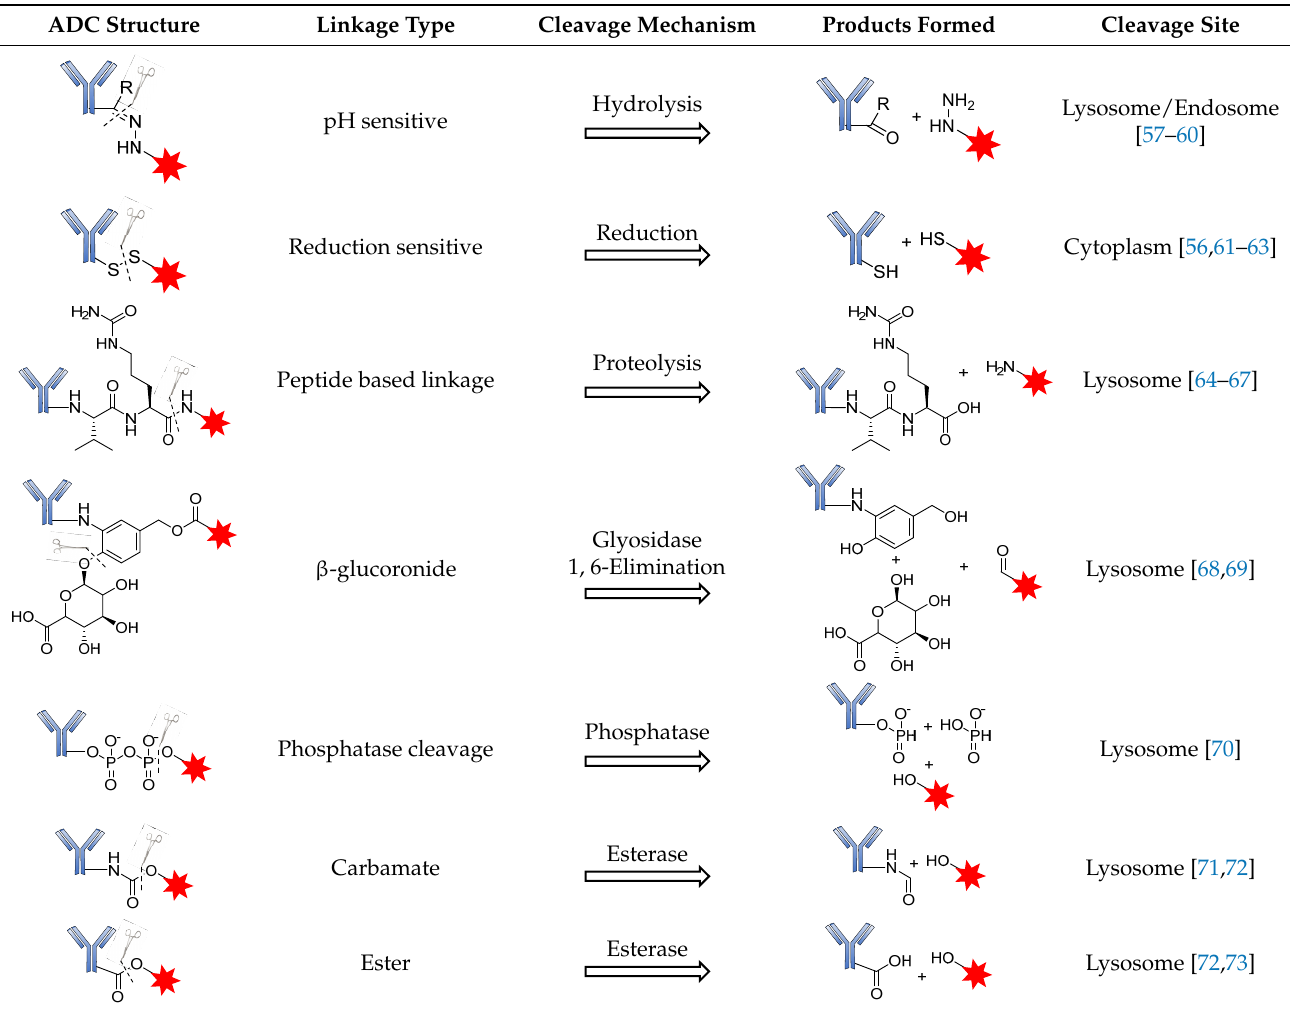
Table 1. A selection of cleavable linkage types, their structures, cleavage conditions, cleavage products, and site of cleavage.